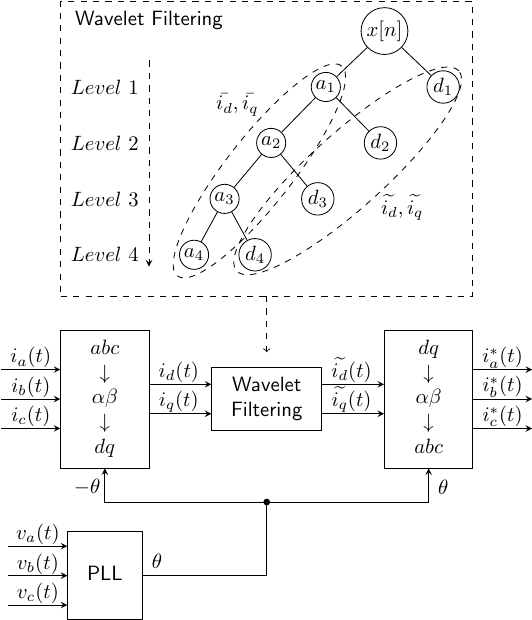
Figure 11. Wavelet Transformation